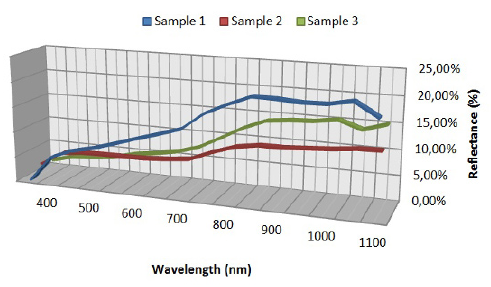
Figure 3. The reflectance curve for three CuInSe 2 films